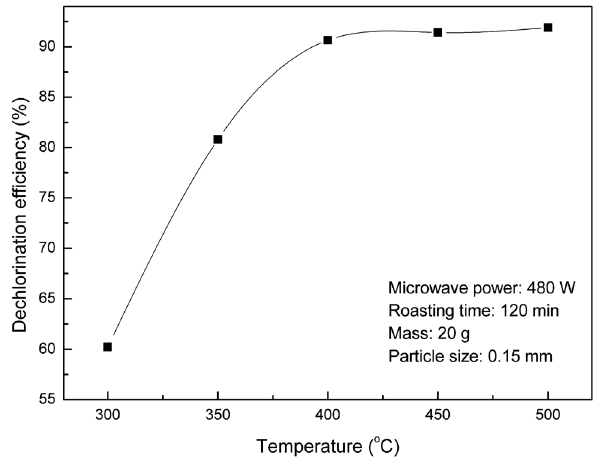
Fig. 3: Effect of temperature on dechlorination efficiency of Cu residue